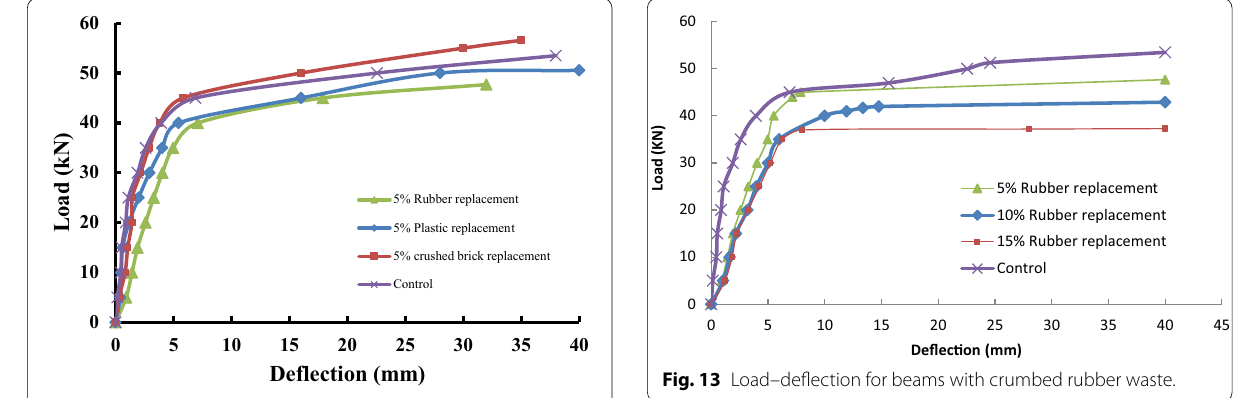
Fig. 10 Load–deflection for beams containing 5% of waste materials.